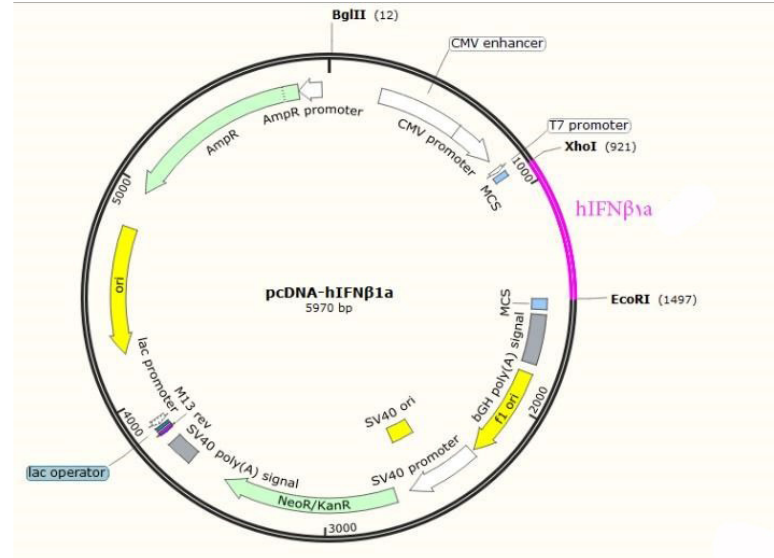
Figure 2. Bioinformatical analysis of hIFN β -1a encoding sequence entry into pcDNA3.1 plasmid by SnapGene